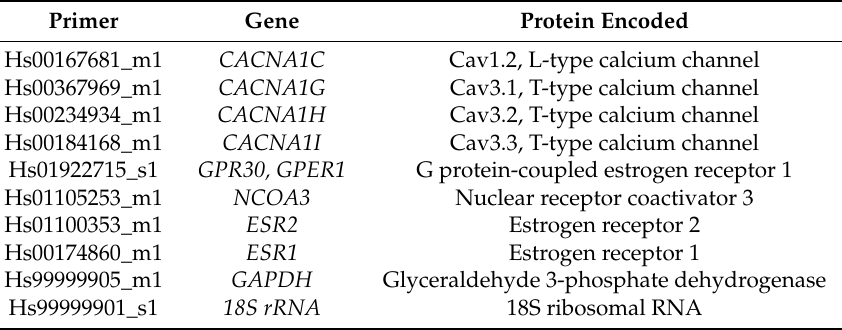
Table 1. Panel of primers (Life Technologies, Carlsbad, CA,